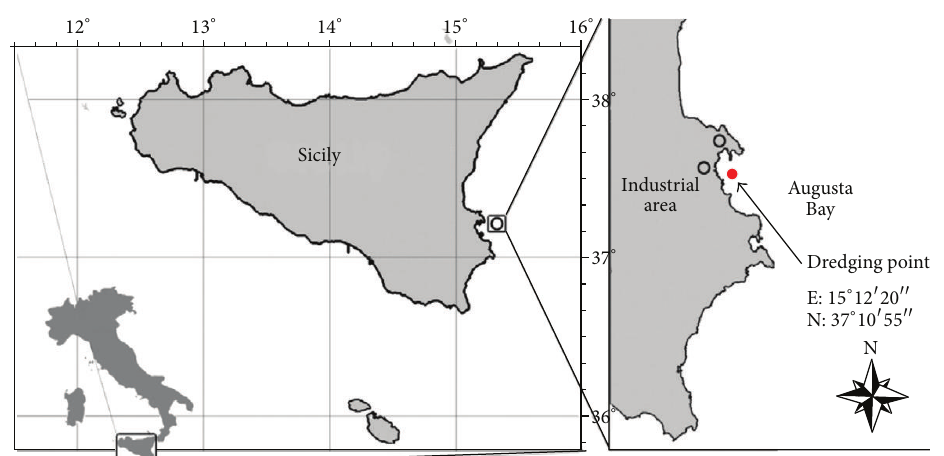
Figure 1: Location of sediment sampling point (Augusta Bay, Syracuse,